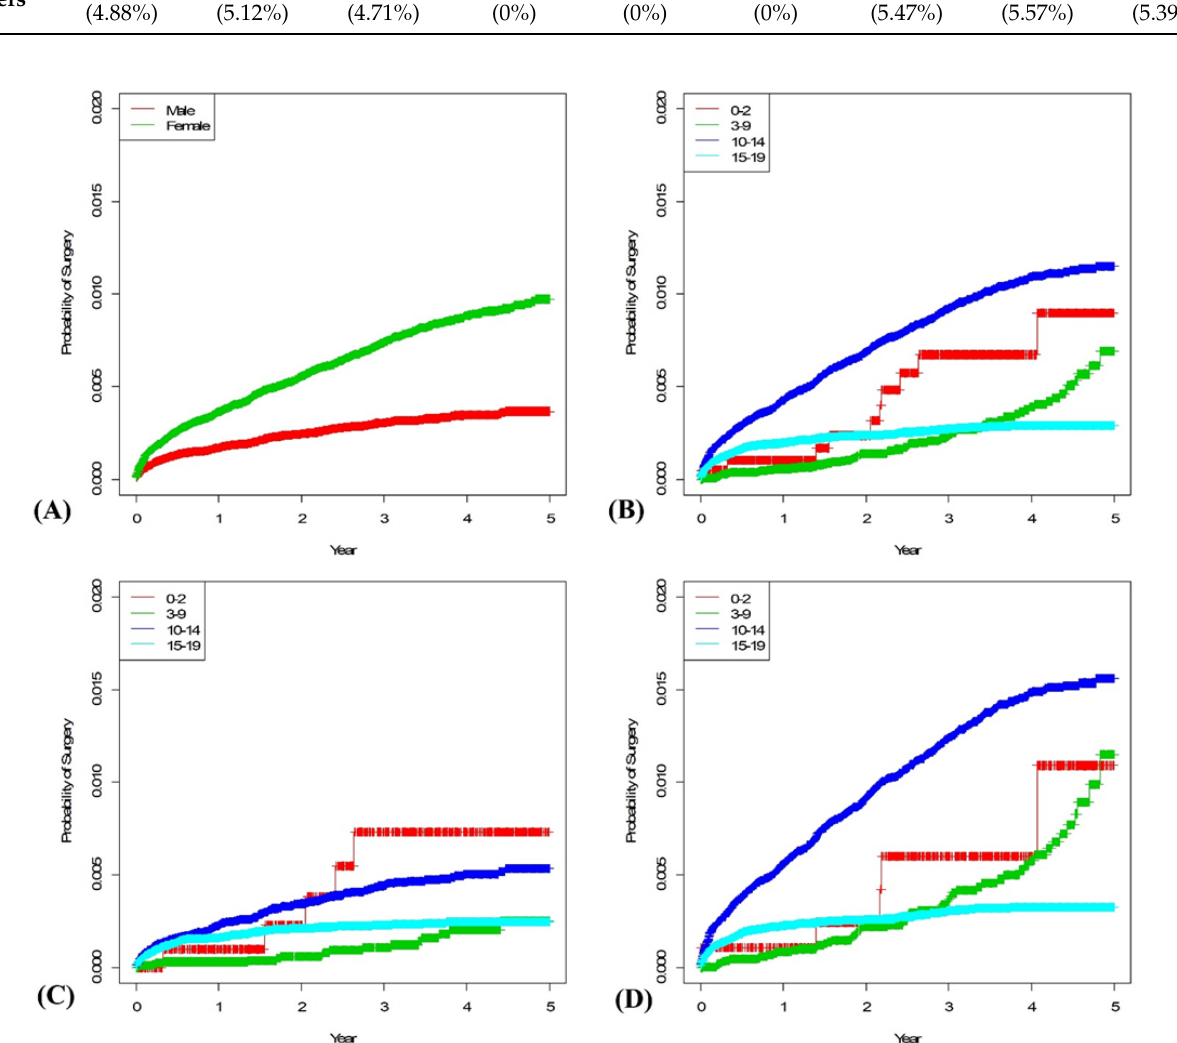
Figure 3. Each graph shows the Kaplan-Meier survival curve of surgery rate of idiopathic scoliosis patients: ( A ) Male vs. female, ( B ) by age group, ( C ) by age group in the male population, and ( D ) by age group in the female population.